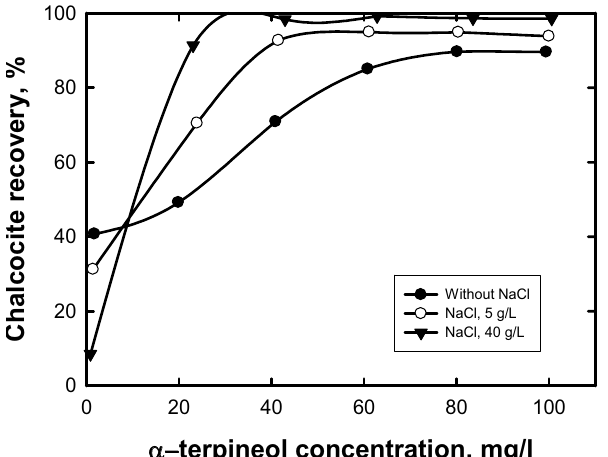
Fig. 7 Flotation of chalcocite as a function of α -terpineol in NaCl solutions (EtX = 3mg/g; pH = 9.7).(Lekki and Laskowski, 1972) 16)